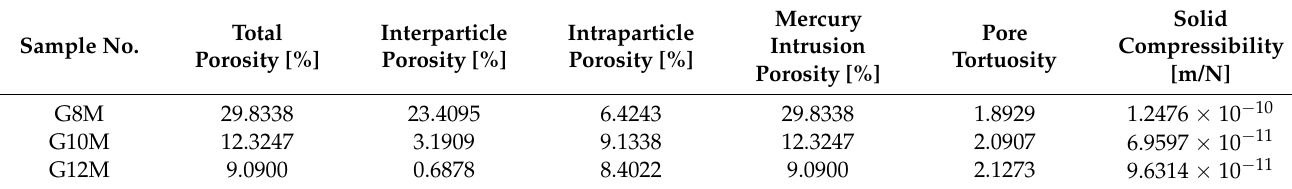
Table 7. Results of porosity test of samples after three years of ageing and resoaking in distilled water and drying.